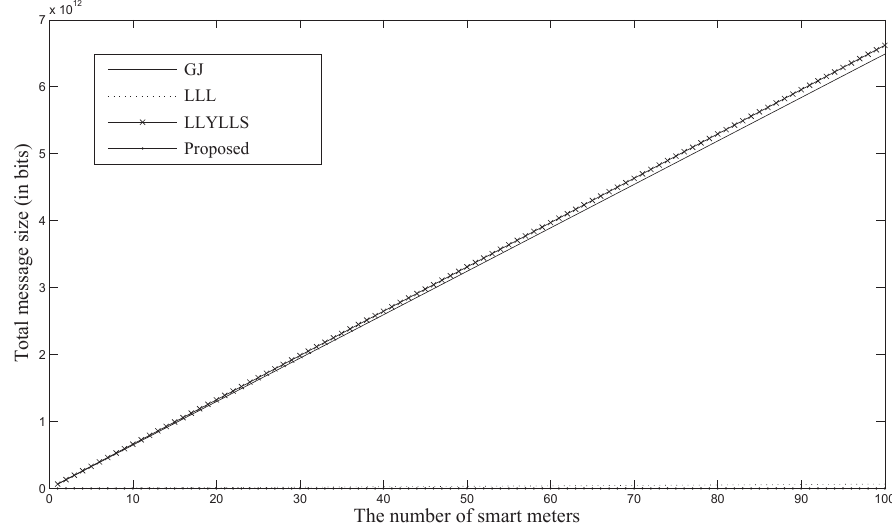
Figure 3. Total message size for an aggregation (linear scale).